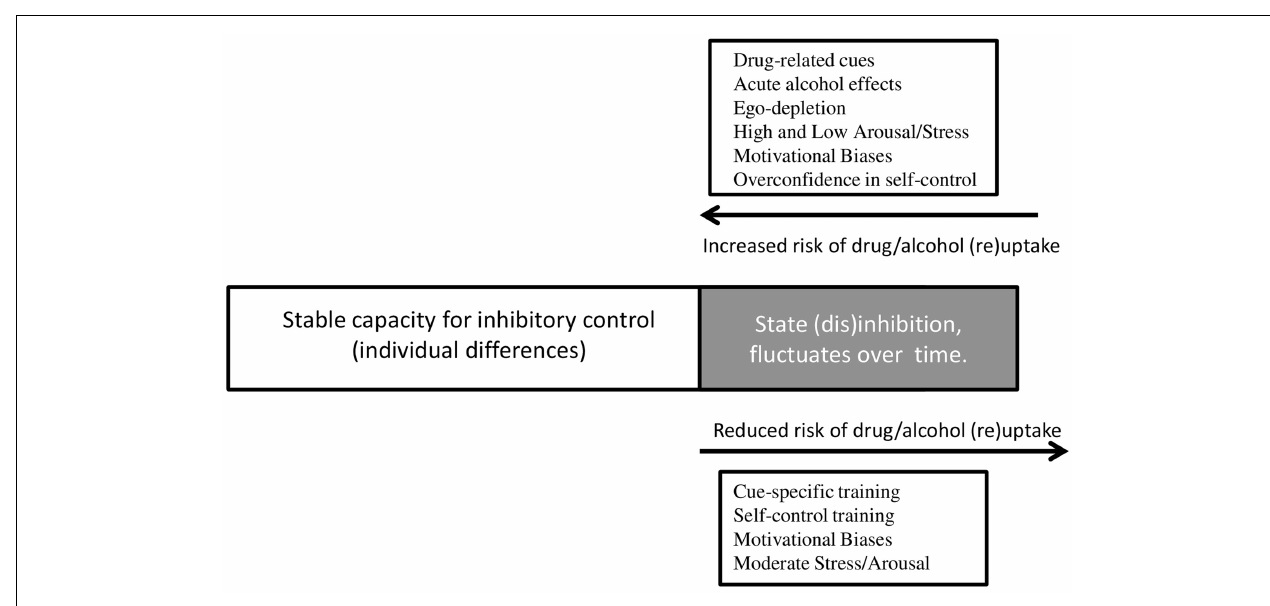
experience a decrease in state disinhibition, they are less likely to engage in substance use, or relapse. Drug-related cues, alcohol intoxication, ego depletion, arousal, stress, motivational biases, and over-confidence all lead to increased disinhibition and thereby increase the risk of substance use. Disinhibition can be reduced after different types of cognitive training, by motivational biases, and by moderate levels of stress and arousal – resulting in a reduced risk of substance